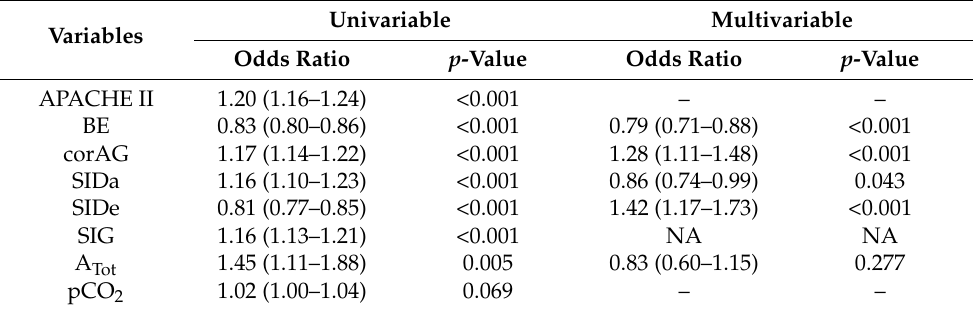
Table 3. Logistic regression models of APACHE II score and parameters assessing acid-base status in predicting mortality in patients with acute pesticide